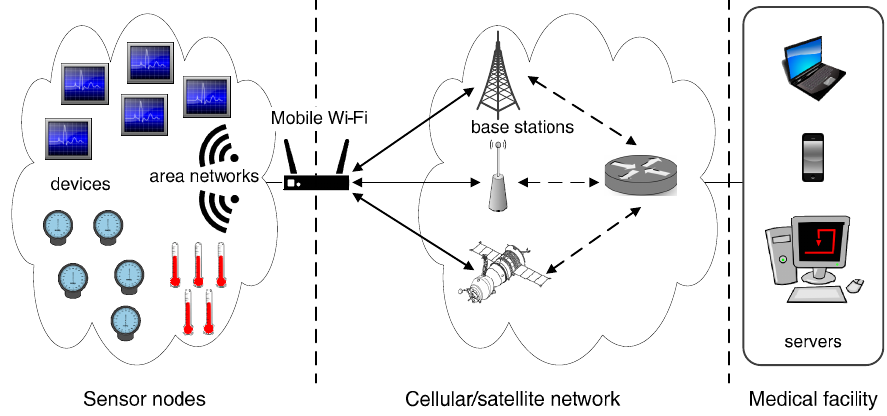
Figure 1. Cyber-physical systems (CPS) Architecture .